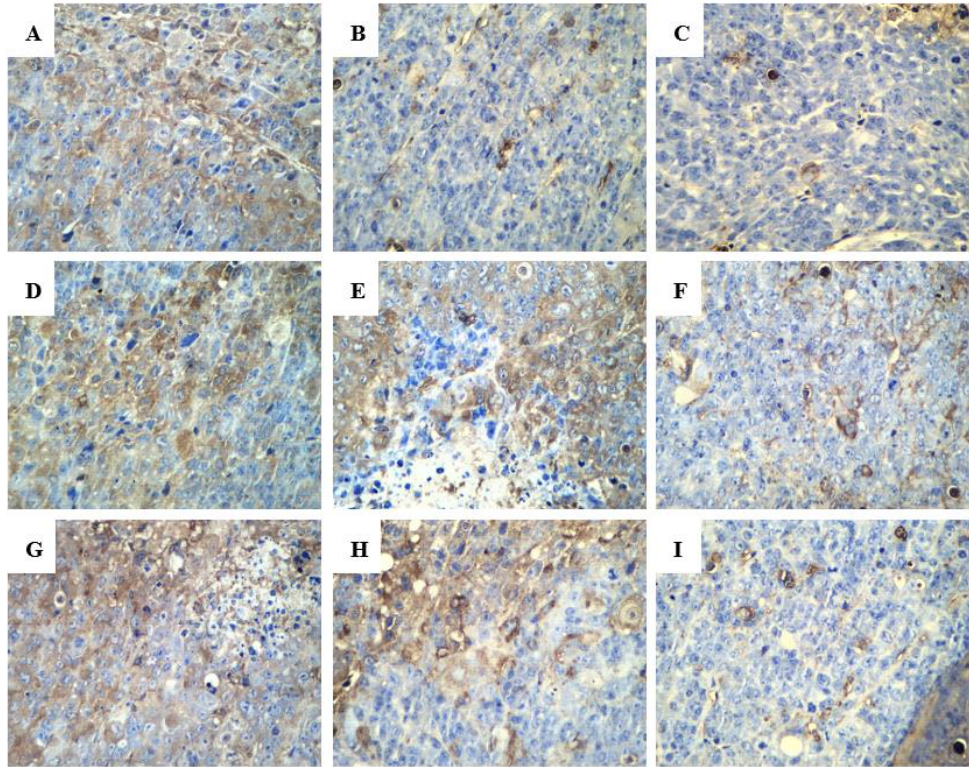
Figure 10. Representative histologic examination of morphological changes in tumors from H22-tumor bearing mice. Protein expression of VEGF in H22-tumor tissues was examined by immunohistochemistry (400 × ). ( A ) Model control, ( B ) CTX, ( C ) Rh 2 -H, ( D ) R-PHQ-L, ( E ) R-PHQ-M, ( F ) R-PHQ-H, ( G ) S-PHQ-L, ( H ) S-PHQ-M, ( I )